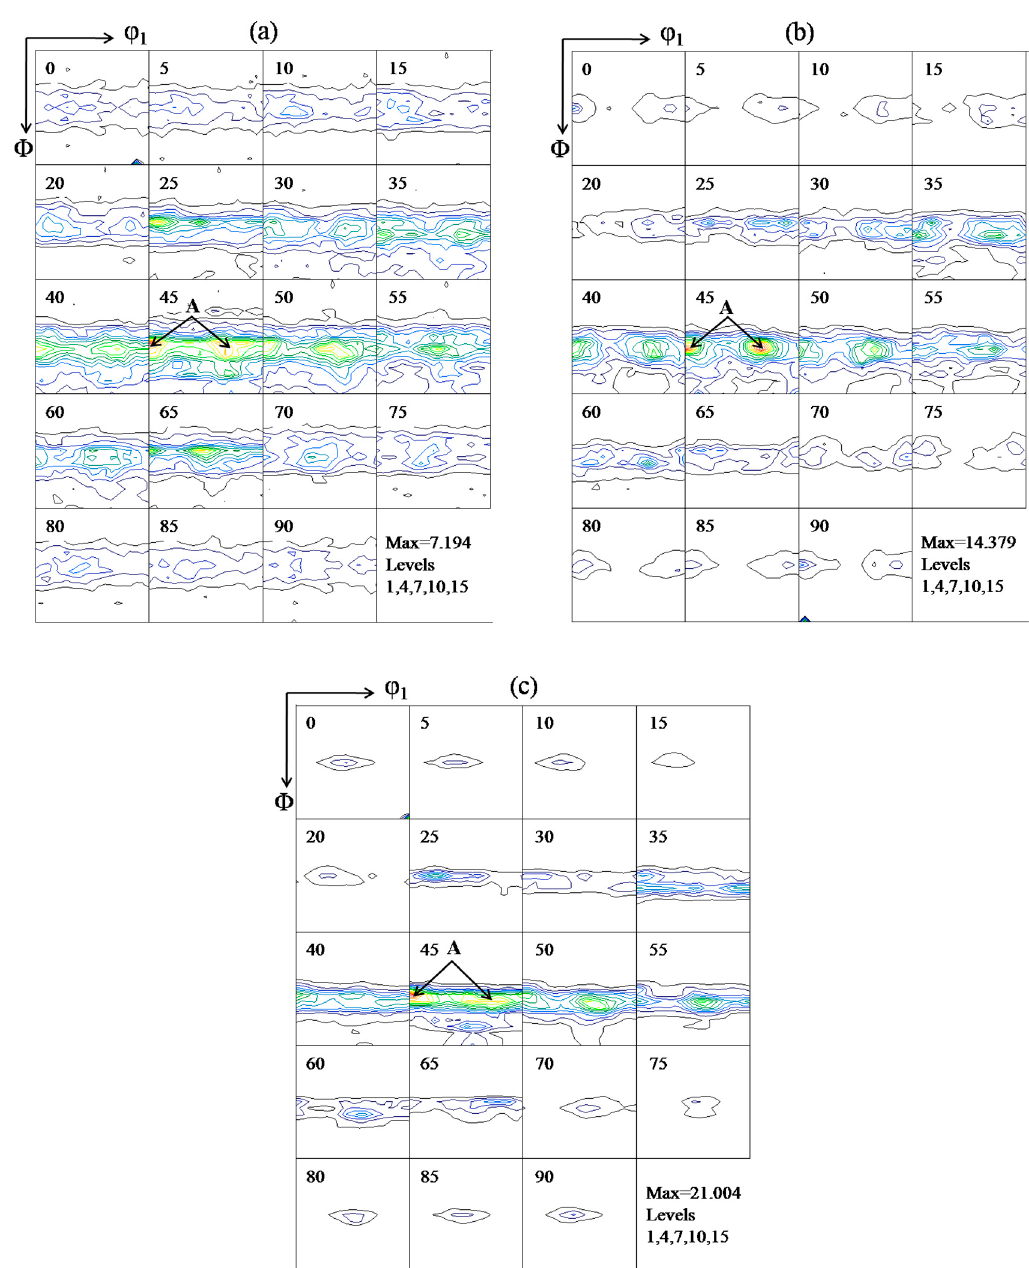
Figure 4. Orientation distribution function (ODF) results of the Ni 47 Ti 44 Nb 9 rods. ( a ) Sample A, ( b ) Sample B and ( c ) Sample C. Point A represents the {111}<110> component.